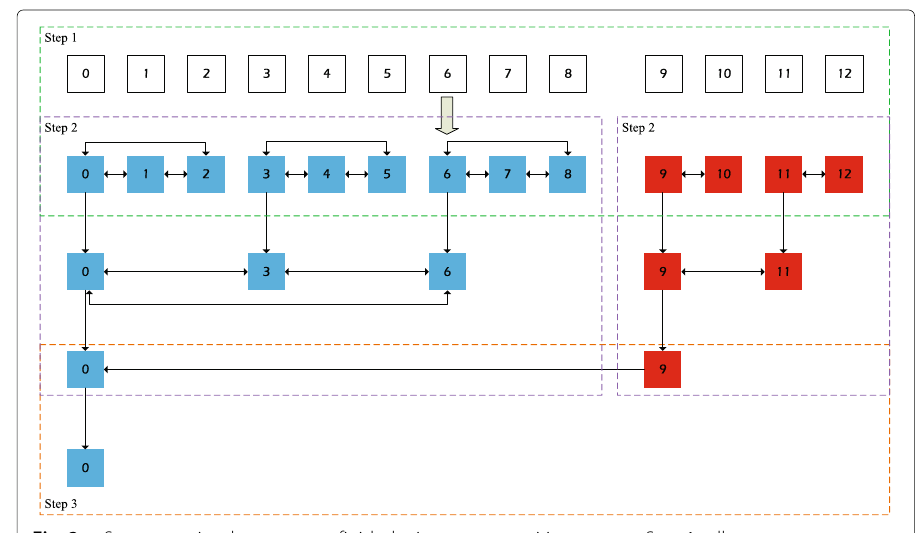
Fig. 2 mSwap contains three steps to finish the image compositing process. Step 1 : all processors are grouped according to the optimal ( m , k ) table. Step 2 : image compositing with m-ary tree in each group. Step 3 : image compositing with Binary Tree between groups